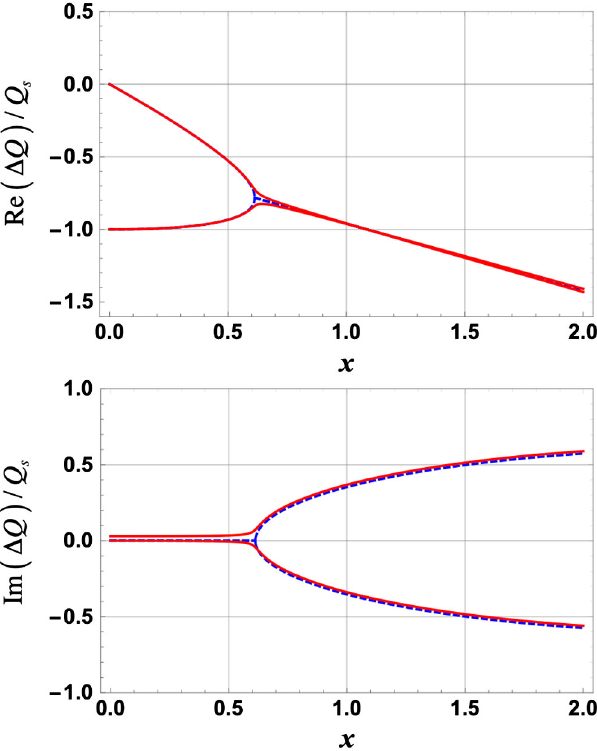
FIG. 5. Solutions of the diagonalization of the 2 by 2 matrix of Eq. (2) vs x a normalized parameter proportional to the bunch intensity [4]: without (dotted blue line) and with (red line) the resistive TD assuming Q s ¼ 0 . 1 and d ¼ 50 turns.